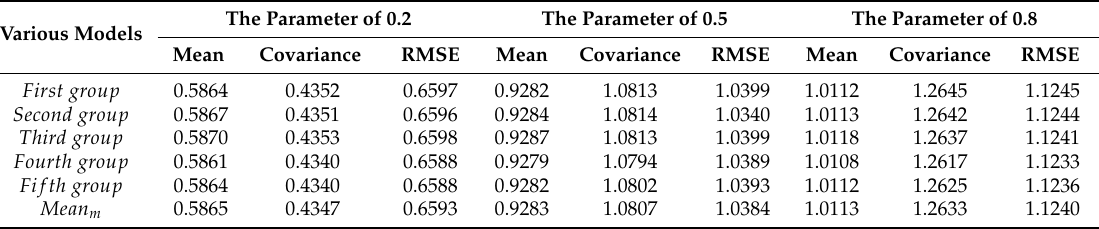
Table 2. Mean, covariance and RMSE of first-order exponential smoothing with different parameters.